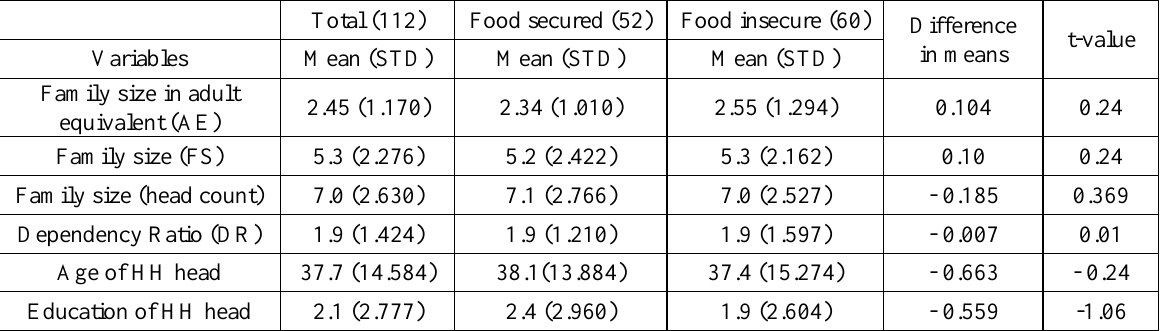
Table 1. Descriptive analysis of the demographic background of the sample household (HH) for the continuous variables